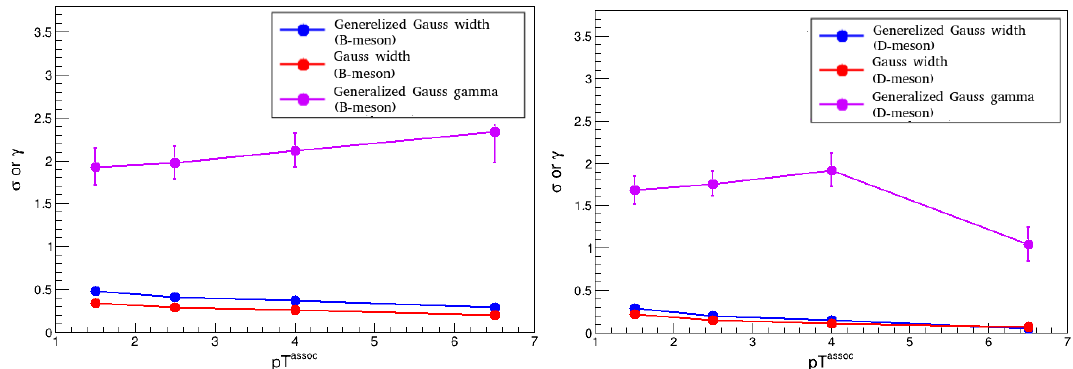
Figure 3. B mesons from b quarks(on the left side) and D mesons from c quarks (on the right side) and < 8 GeV/ c and different p assoc for 5 < p trigger T T